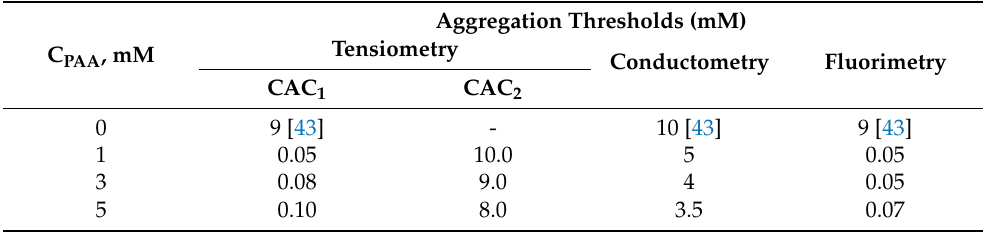
Table 1. Aggregation thresholds of the IA-12/PAA binary systems obtained by different physico- chemical